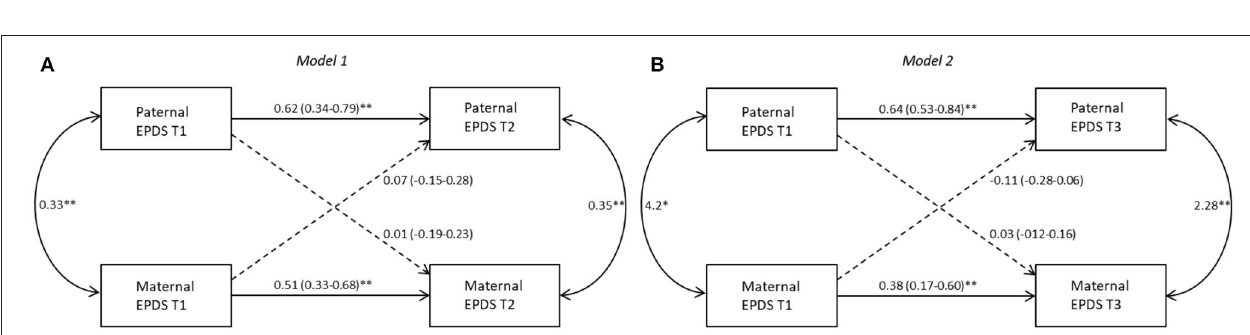
FIGURE 2 | Actor-partner interdependence models for depression in VLBW group 95% CI are reported in parentheses; * p ≤ 0.05; ** p ≤ 0.01. Note . (A) Model 1: T1D- > T2D, (B) Model 2: T1D- > T3D. Black lines represent significant paths, dashed lines represent non-significant paths.